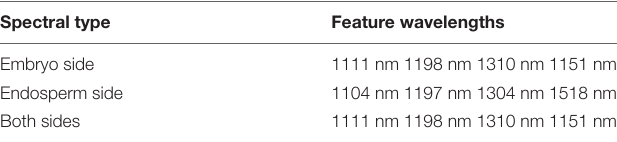
TABLE 1 | The classification results based on original spectra using SVM algorithm.